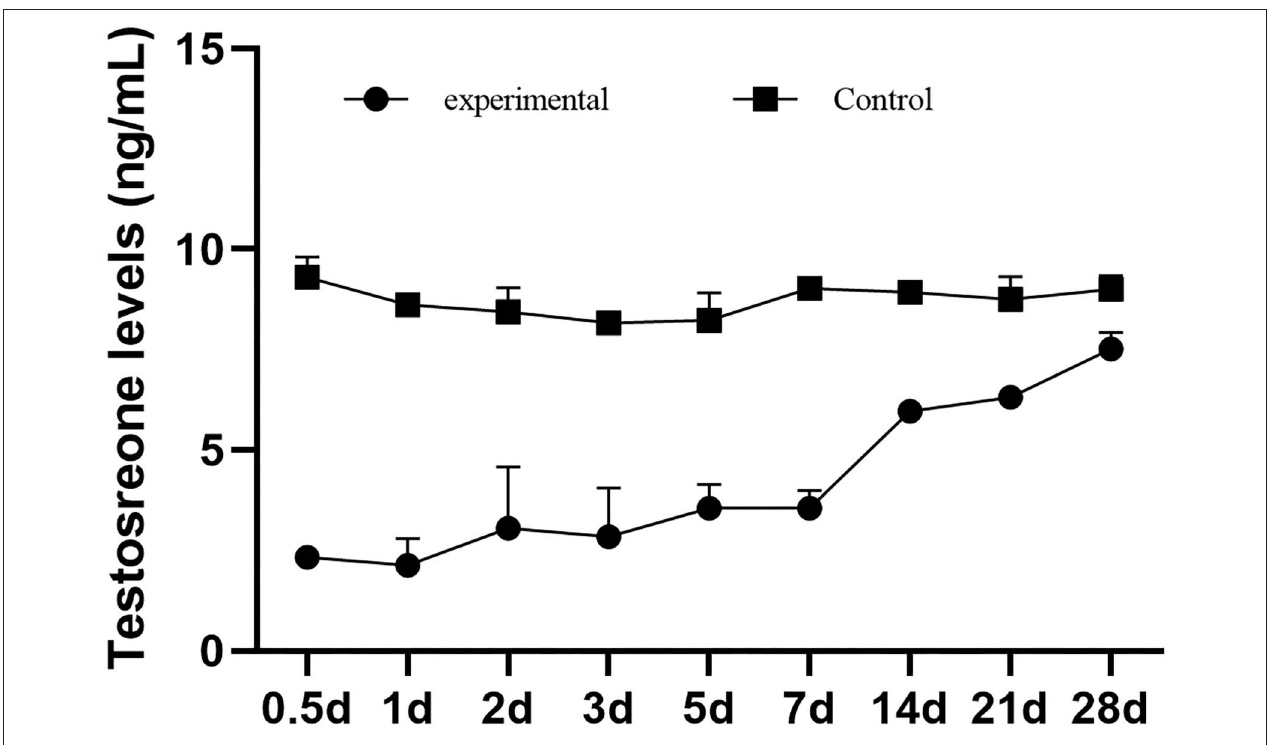
FIGURE 3 | The testosteron levels of male mice in